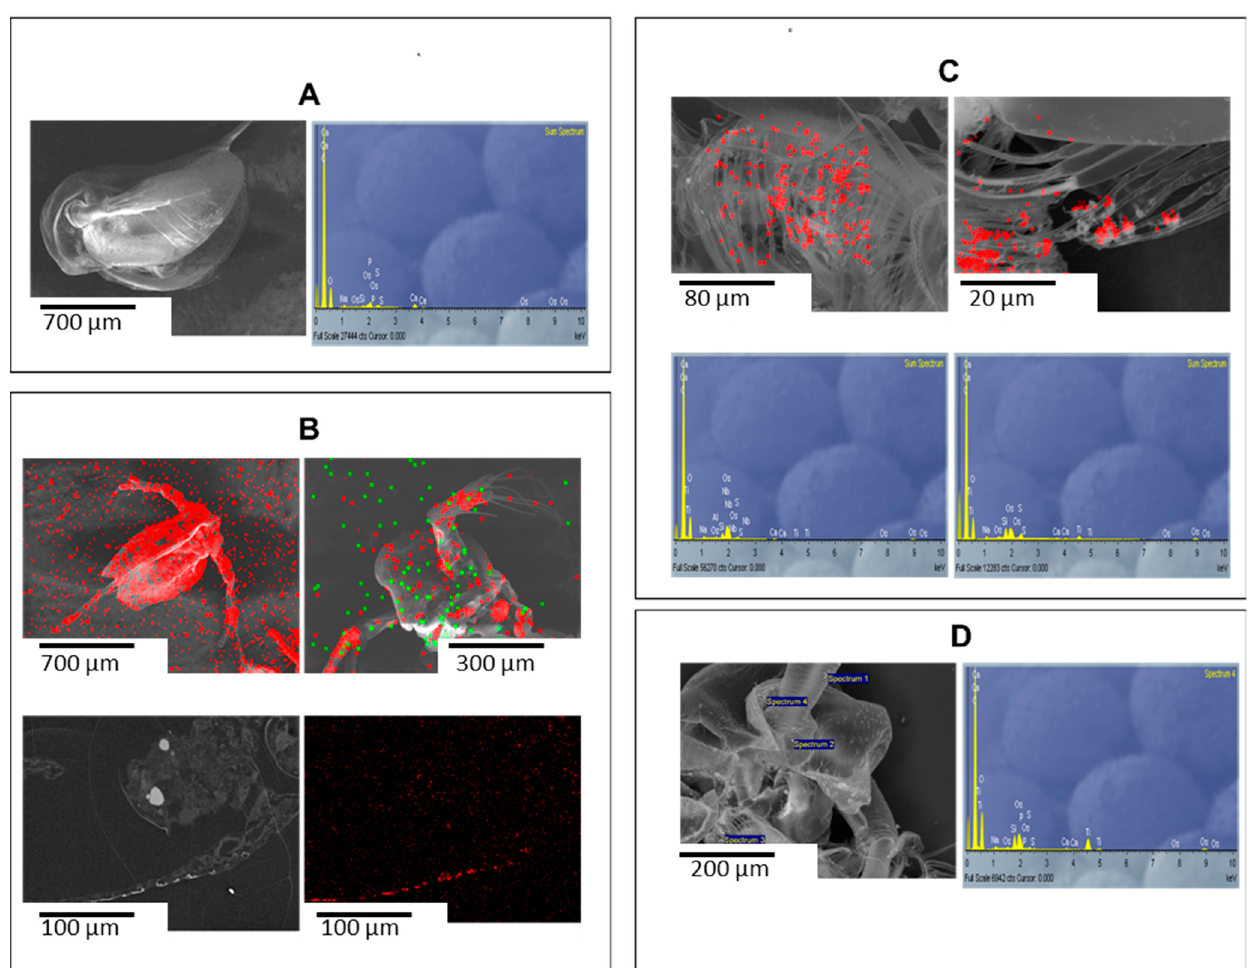
Figure 8. SEM-EDS images illustrating unaffected D. magna ( A ) control and adsorption of SUN1 ( B ), SUN2 ( C ) and SUN3 ( D ) PR-ENMs on morphological damaged D. magna after 48 h exposure (100% ( v / v )).